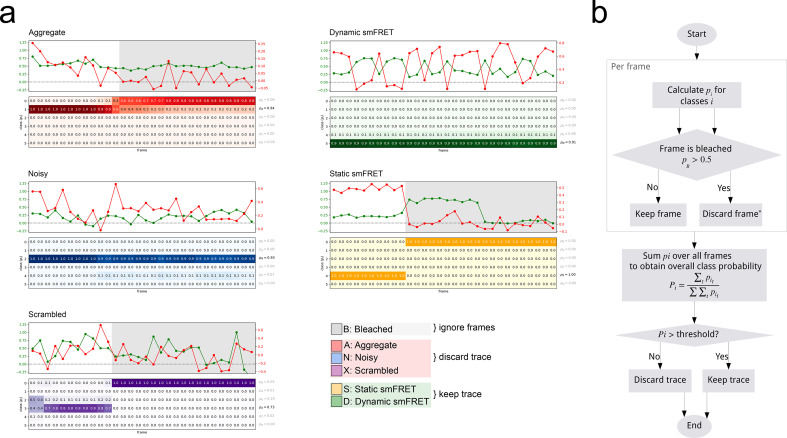
Calculation of confidence score from model predictions.(a) Short toy-examples of selected traces for each category and the corresponding frame-wise predictions used for calculating confidence scores. The color code corresponds to classified behavior. All bleached data points (marked with gray in the trace) are excluded from the confidence score calculation. (b) Step-by-step calculation of trace scores.